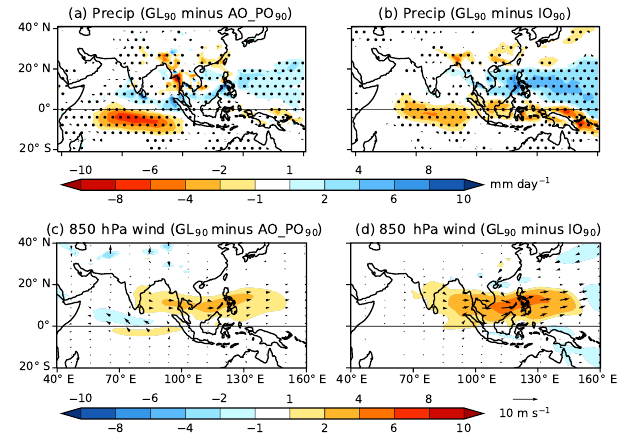
Figure 3. (a, b) JJAS mean precipitation (mmday − 1 ) in GL 90 mi- nus that from (a) AO_PO 90 , (b) IO 90 . Stippling indicates 99% sta- tistical significance according to a two-tailed t test. (c, d) Similar but for 850hPa wind (ms − 1 ), with vectors (shown only if statisti- cally significant at the 99% level according to a two-tailed t test) and coloured shading as defined in Fig. 2e.